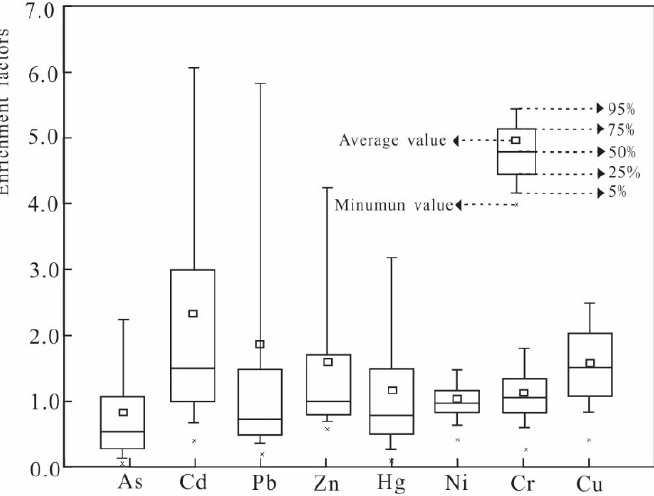
Figure 2. The enrichment factors (EFs) of heavy metals in topsoil. Table 2. Environmental risk levels of heavy metals in study area.